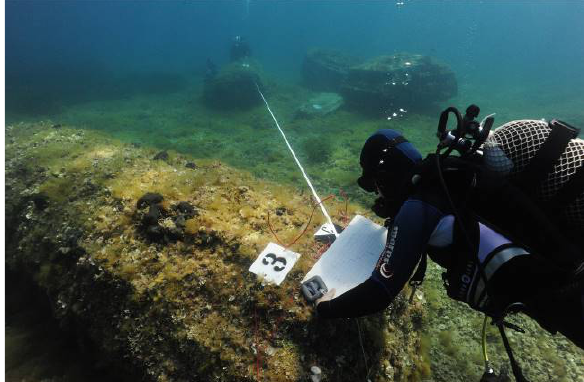
Figure 7. Cape Granitola shipwreck. Antenna of GPS RTK.